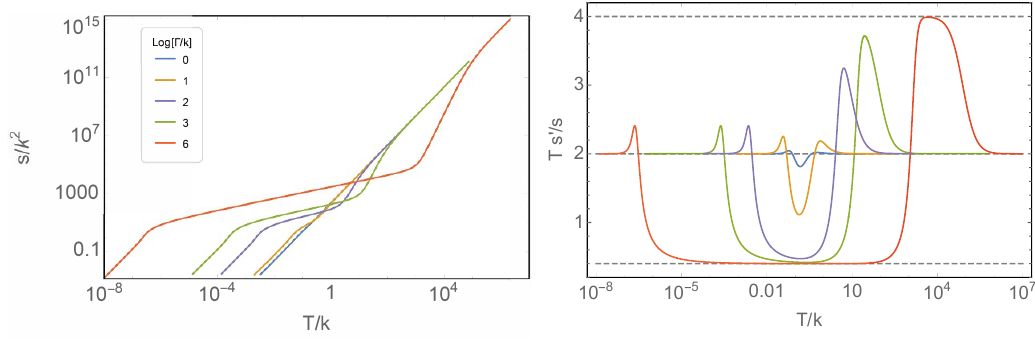
Figure 4 . Behaviour of the entropy density, s , as a function of temperature, for various boomerang RG (cid:13)ows: blue ((cid:0) =k = 1), orange ((cid:0) =k = 10), purple ((cid:0) =k = 10 2 ), green ((cid:0) =k = 10 3 ) and red ((cid:0) =k = 10 6 ). In the UV and in the IR we have Ts 0 =s ! 2, associated with AdS 4 . We also see,